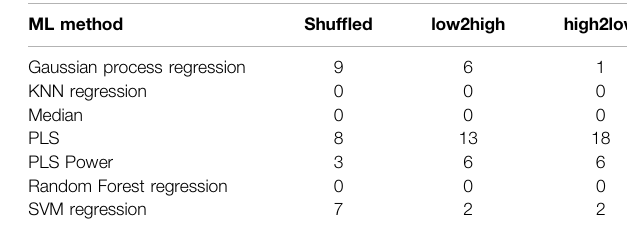
TABLE 3| Summaryofthebest results forthemachinelearning techniques. Rank count for the top three ranks. The ranks were calculated from all descriptors, predicted properties, and fractions of training data. The columns show the three different orientations of the response data: shuf fl ed, sorted from high to low and from low to high.